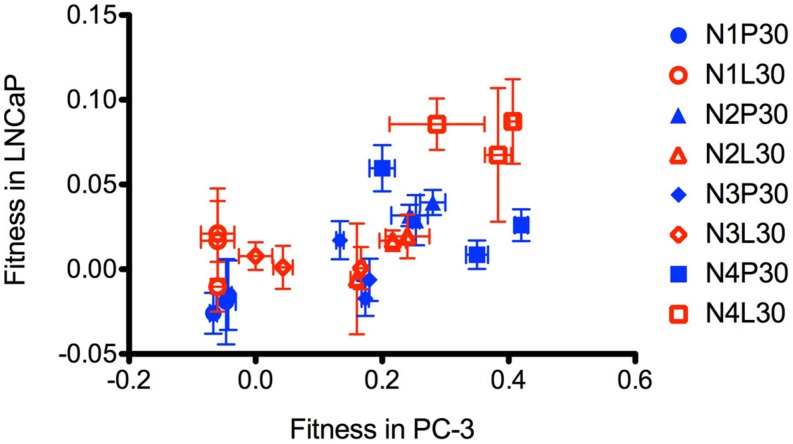
Plot of fitness calculated relative to ancestor in PC-3 versus LNCaP cells. Mean and SD of three replicates for each evolved strain are shown. LNCaP evolved strains are open shapes in red, PC-3 evolved strains are closed shapes in blue. N1 are circles, N2 are triangles, N3 are diamonds, and N4 are squares.